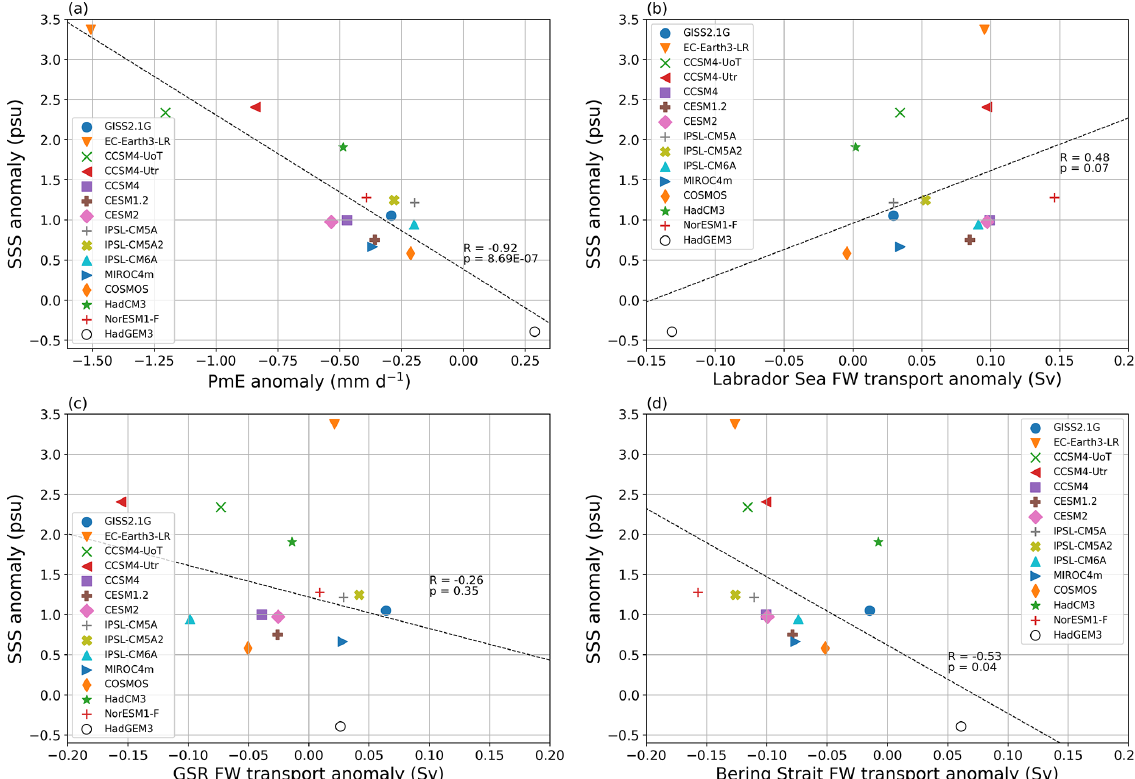
Figure 9. The mPWP–PI change in sea surface salinity plotted against (a) the mPWP–PI change in PmE freshwater flux, (b) the mPWP–PI change in northward freshwater transport at the northern boundary of the Labrador Sea (62 ◦ N), (c) the mPWP–PI change in northward freshwater transport across the GSR (62 ◦ N) and (d) the mPWP–PI change in northward freshwater transport across the Bering Strait. The sea surface salinity and PmE anomalies are averaged over the eastern subpolar North Atlantic and Labrador Sea (45–65 ◦ N, 30–60 ◦ W; the area indicated by the blue box in Fig. 6b).